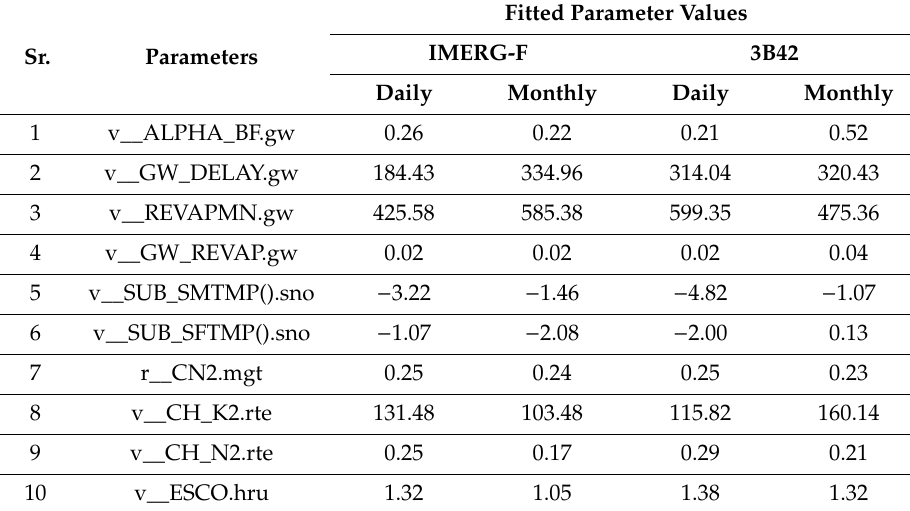
Table 5. Fitted parameter values of IMERG-F and